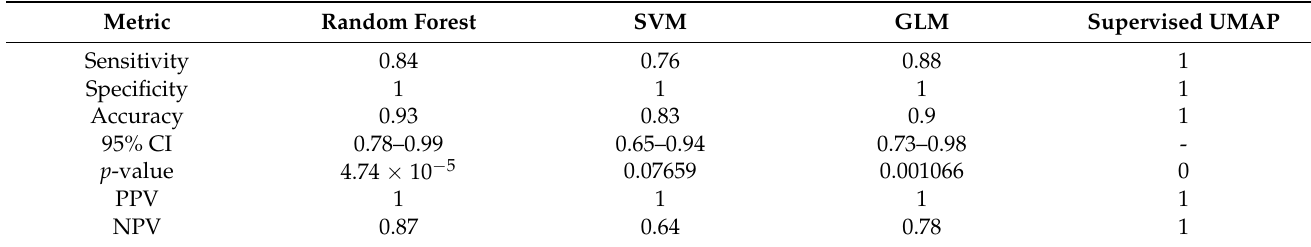
Table 3. Supervised Model metrics for classification of chRCC and